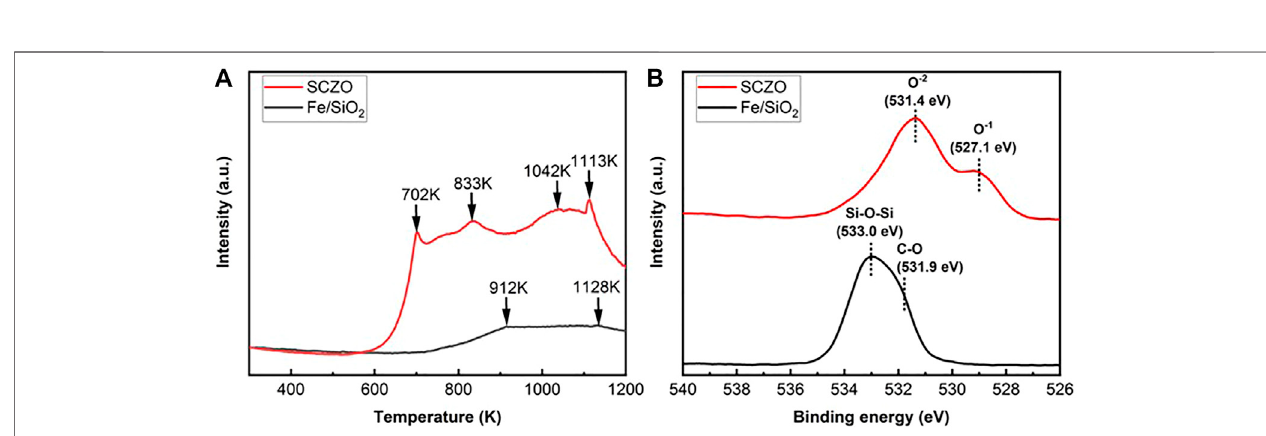
FIGURE 1 | SEM images showing morphologies of Fe/SiO 2 catalyst (A) and SCZO perovskite oxide (B) particles. (C) and (D) are the XRD data and N 2 adsorption – desorption isotherms of both materials.